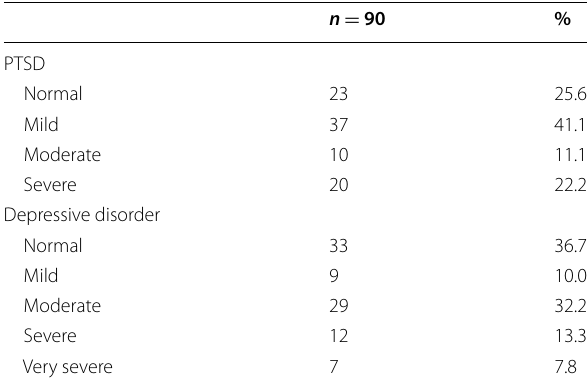
Table 3 Depressive disorder and post-traumatic stress